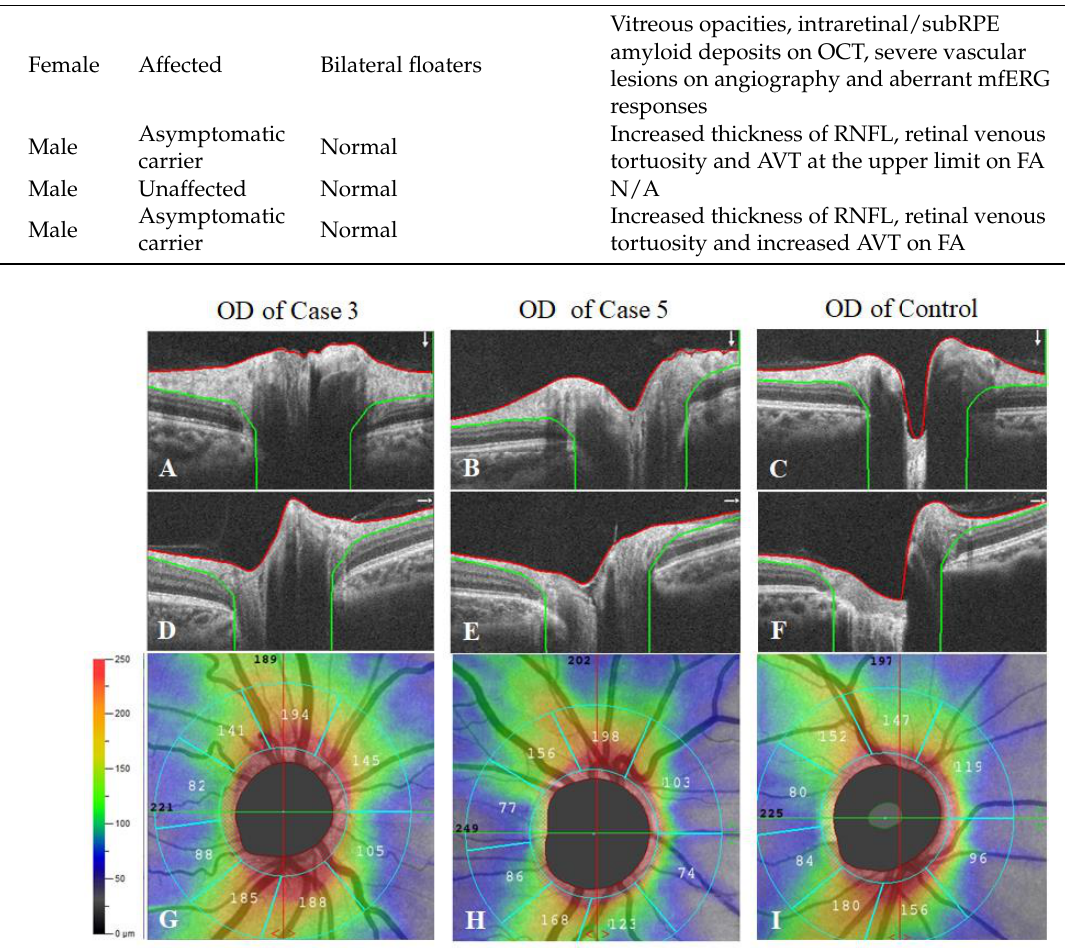
Figure 6. Measurement of the Retinal Nerve Fiber Layer (RNFL) Thickness. ( A – C ) Vertical scans of the right eyes from case 3, case 5 and the healthy control. ( D – F ) Horizontal scans of the right eyes from case 3, case 5 and the healthy control. ( G – I ) Representative optical coherence tomography angiography images showing the RNFL thickness around the optic disc in the right eyes from case 3, case 5 and the healthy control.